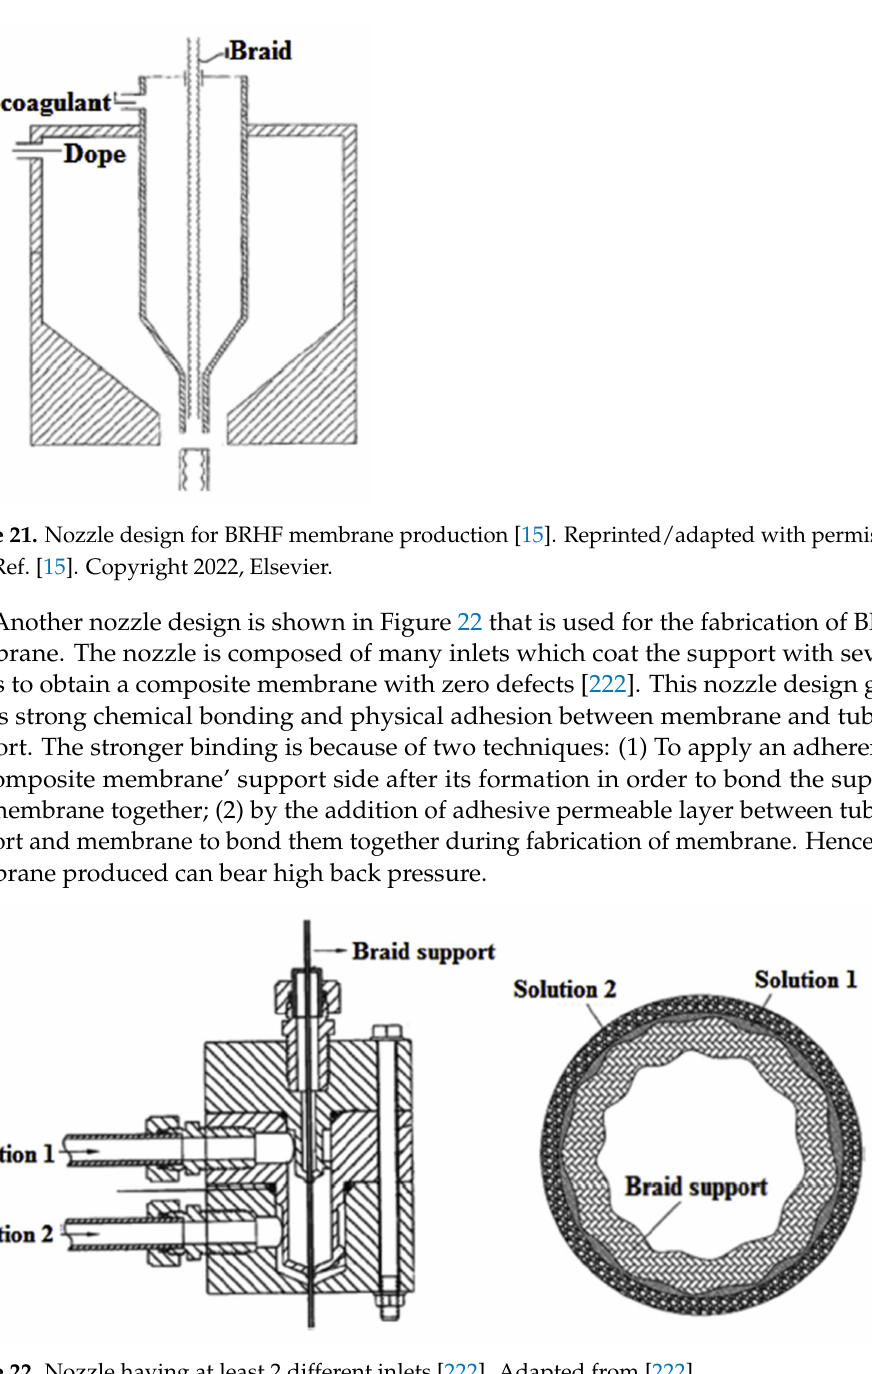
Q = Dope solution feed rate (ml/min); ρ = dope solution density; ϑ = braid advancing speed; D o = braid outer diameter; T = dope solution